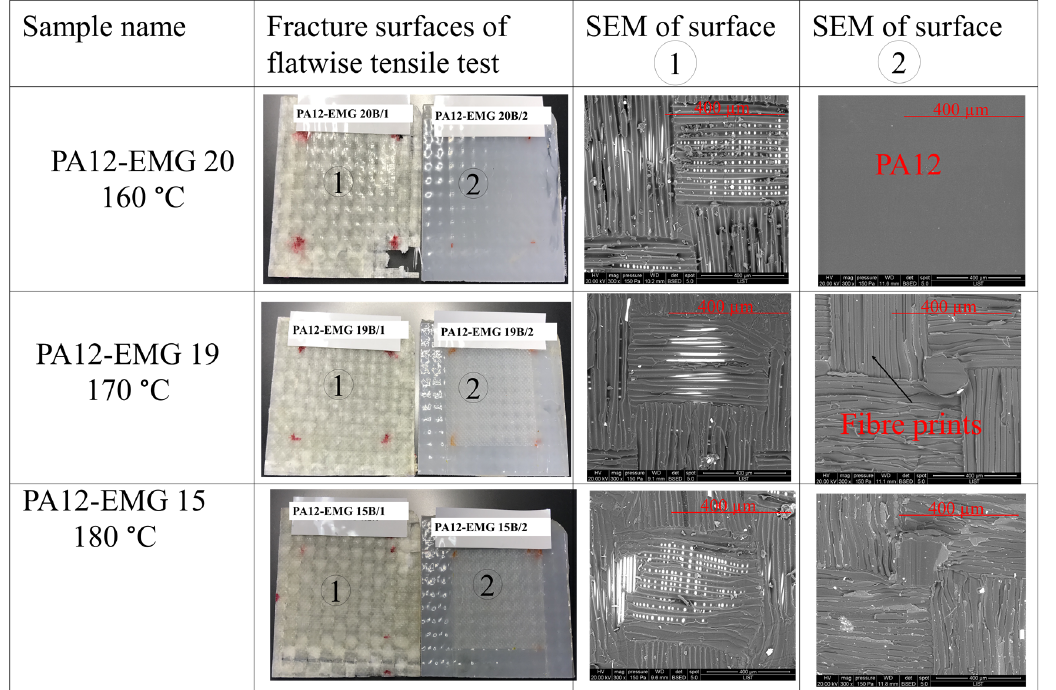
Figure 8. Fracture surfaces and SEM images of PA12-EMG specimens welded at temperatures of 160 °C, 170 °C, and 180 °C. The surface 1 stands for the EMG composite and the surface 2 stands for the interposed PA12 sheet.